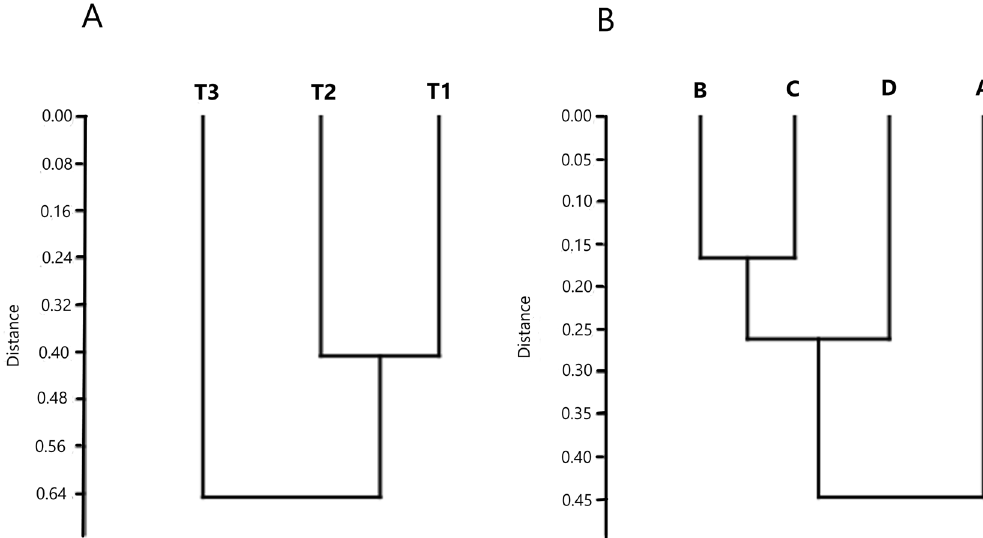
Figure 6. Cluster of community structure. Cluster analysis showing the similitude in Euclidean distance between sampling points from Salar de Tara and between depth